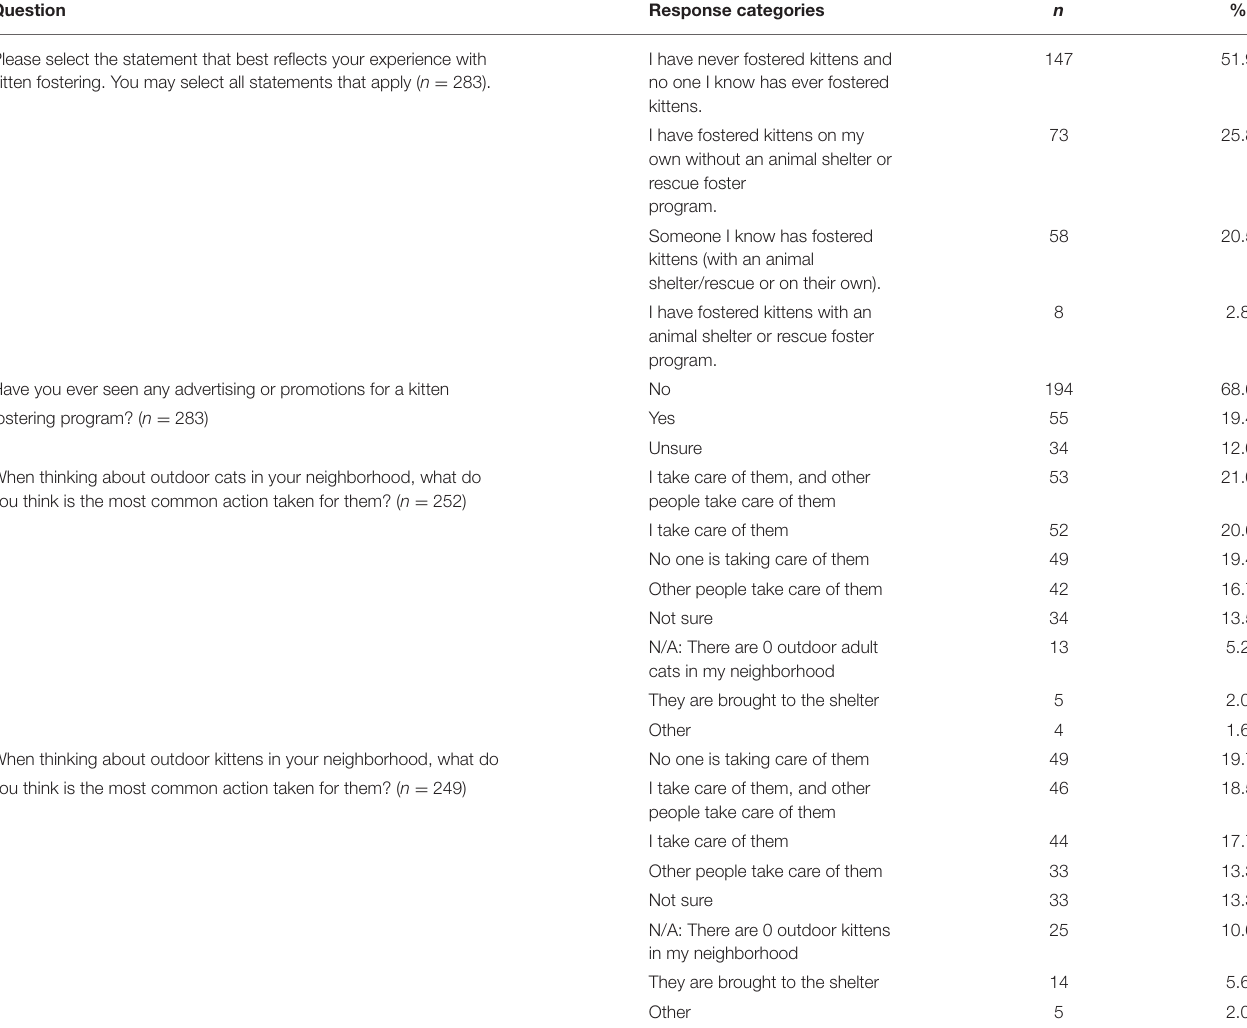
TABLE 2 | Fostering experience, program awareness, and knowledge of kitten overpopulation issues. Question Response